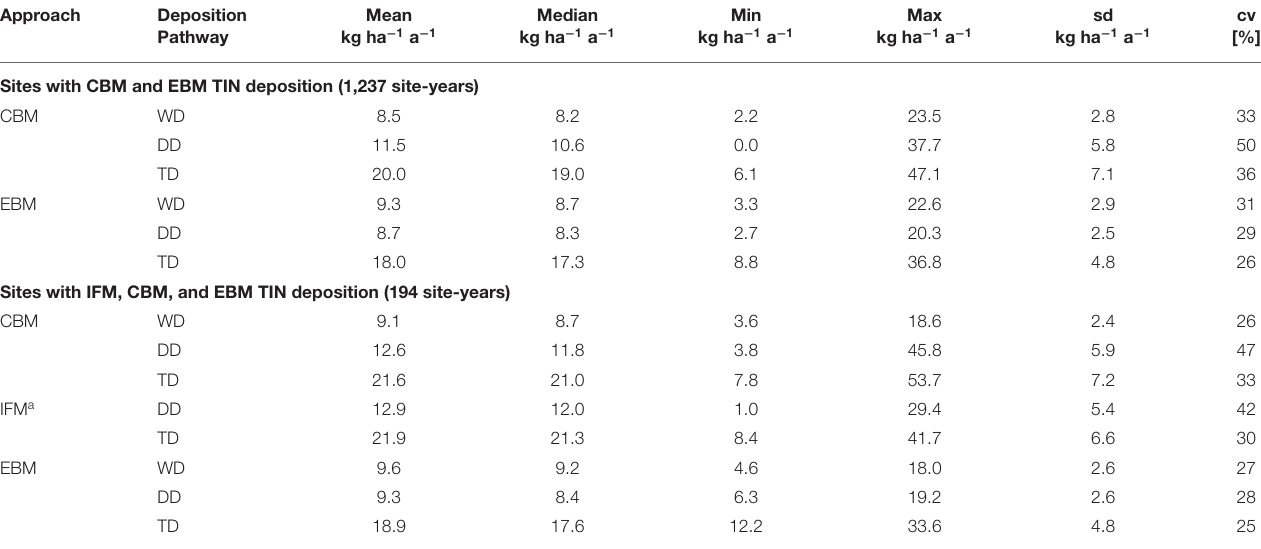
TABLE 5 | Descriptive statistical values of the three approaches for estimation of total inorganic nitrogen (TIN) deposition (canopy budget–CBM; inferential method–IFM; emission based–EBM) for the different deposition pathways [wet deposition (WD), dry deposition (DD), and total deposition (TD)].